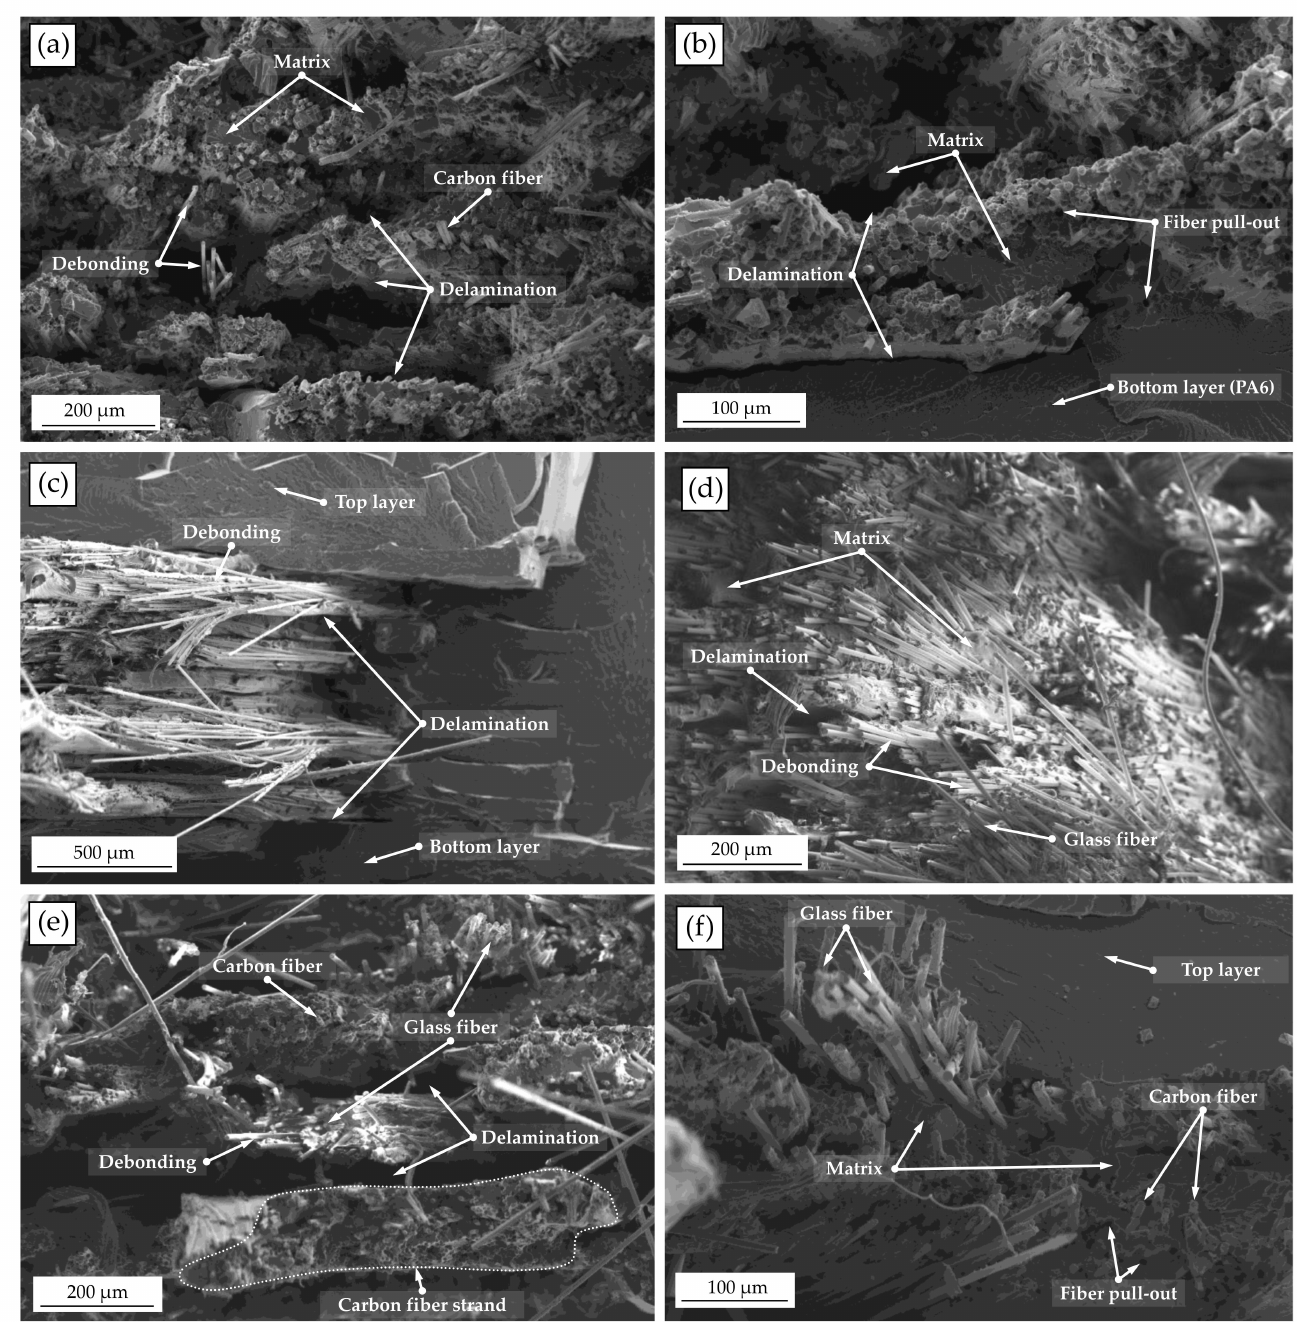
Figure 16. SEM images of the fracture surfaces: ( a , b ) carbon fiber-reinforced specimens, ( c , d ) glass fiber-reinforced specimens, and ( e , f ) hybrid